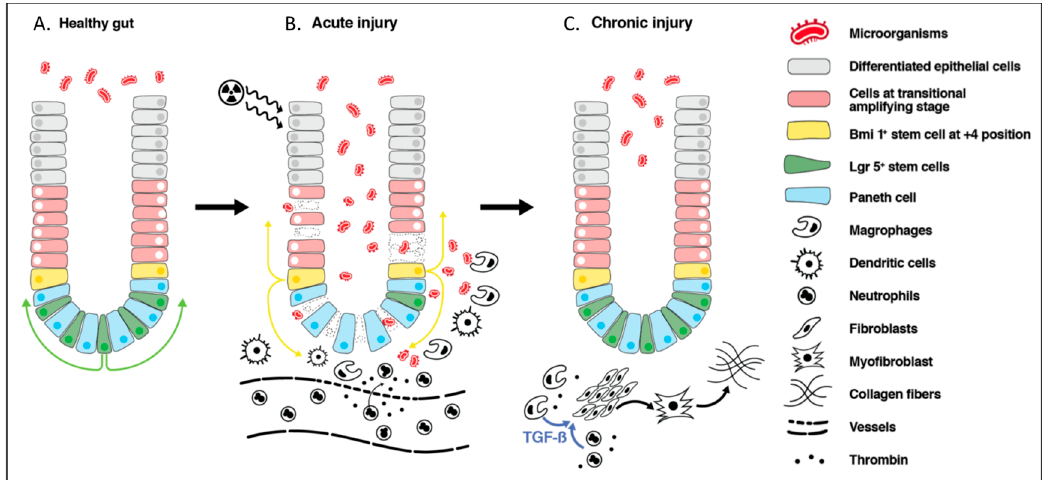
Figure 2. Schematic representation of radiation-induced intestinal injury. ( A ): In healthy gut, crypts are sterile with intact mucosa. Lgr5 + stem cells proliferate and cells migrate upwards to provide differentiated epithelial cells of the villi. Bmi1 + stem cells located at the +4 position remain quiescent. ( B ): In the acute phase of radiation-induced injury, there is loss of epithelial barrier integrity, leading to an influx of antigenic material, including microorganisms into the lamina propria. This induces inflammation orchestrated by macrophages, dendritic cells, and recruited neutrophils from the circulation. Further inflammation is caused by endothelial cell damage and the release of thrombin. Mitotically active Lgr5 + cells undergo apoptosis where as Bmi1 + cells at the +4 position are resistant to radiation insult and acquire an Lgr5 + phenotype to act as a stem cell reservoir. ( C ): Despite epithelial barrier restoration, during the chronic phase of injury, there is an increase in the TGF- β that is secreted by macrophages and neutrophils, which promotes the differentiation of the fibroblast into myofibroblast, leading to collagen deposition and fibrogenesis.